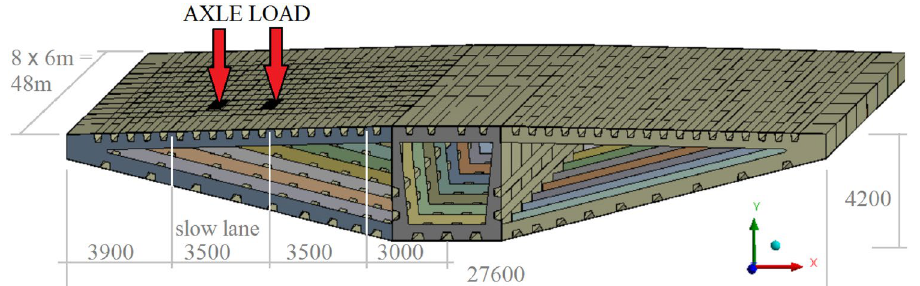
Fig. 5 Finite element model of the part of the deck